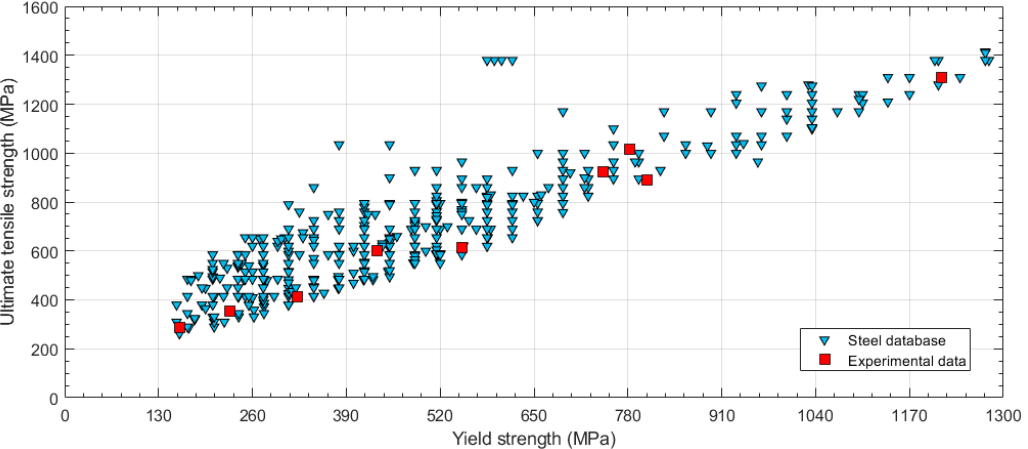
Figure 2. Steel database obtained from the ASME Boiler and Pressure Vessel Code (BPVC)-IIA and experimental data selection (ultimate tensile strength vs. yield strength).